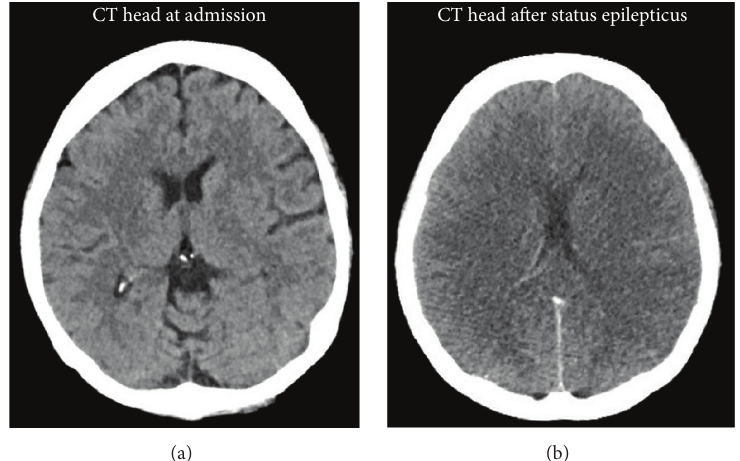
Figure 1: Computed tomography of the head at admission and at onset of status epilepticus. Computed tomography (CT) of the head (a) showed no remarkable findings on the day of admission and (b) showed diffused brain swelling consistent with cerebral edema on 12th day.